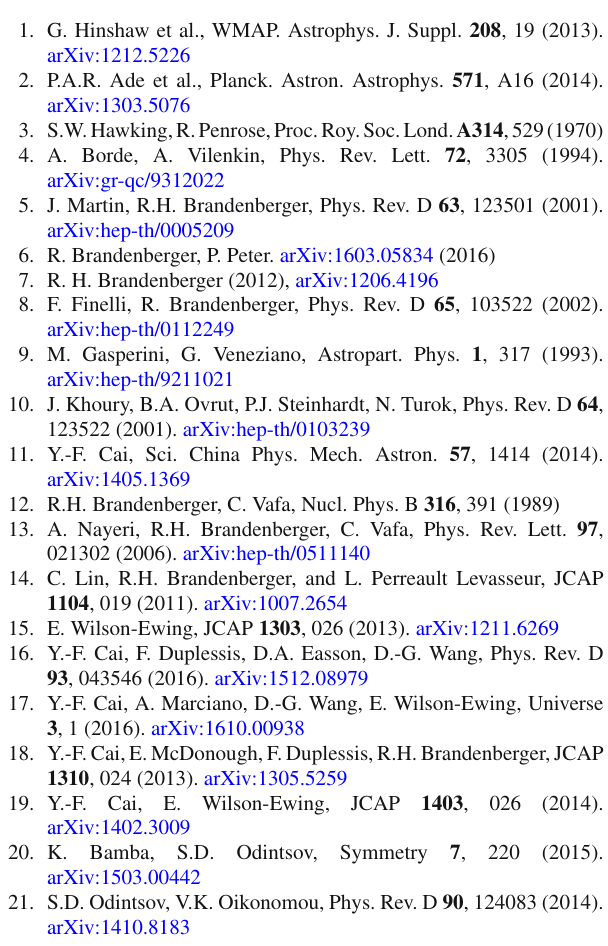
Commons license, and indicate if changes were made. Funded by SCOAP 3